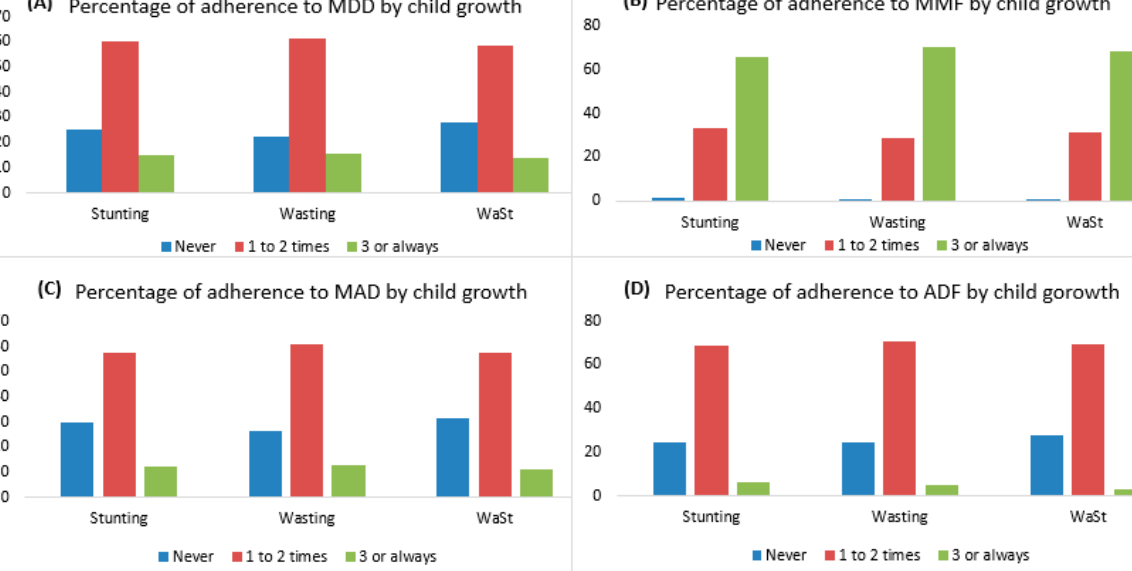
Table 4. The relationship of adherence to age-appropriate feeding practices and other determinants with child height-for-age (HAZ).